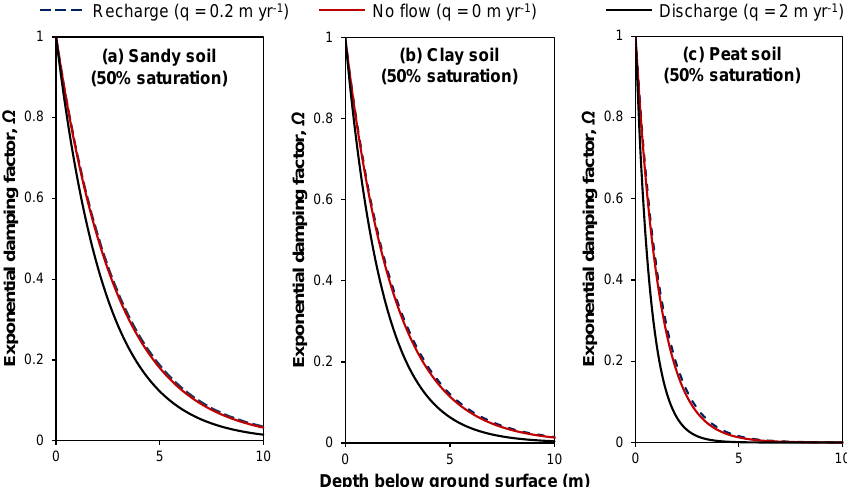
Figure 6. Exponential damping factor (seasonal temperature sensitivity) (cid:127) (Eq. 8) vs. depth for (a) sandy soil, (b) clay soil, and (c) peat soil. The thermal properties were taken from Table 2 assuming a volumetric water saturation of 50%. Results are presented for Darcy velocities of 0.2myr − 1 (recharge; downwards flow), 0 (conduction-dominated thermal regime), and − 2myr − 1 (discharge; upwards flow) and a period of 1 year. A higher discharge value was used in comparison to the recharge value given that discharge is typically concentrated over a smaller area than recharge.